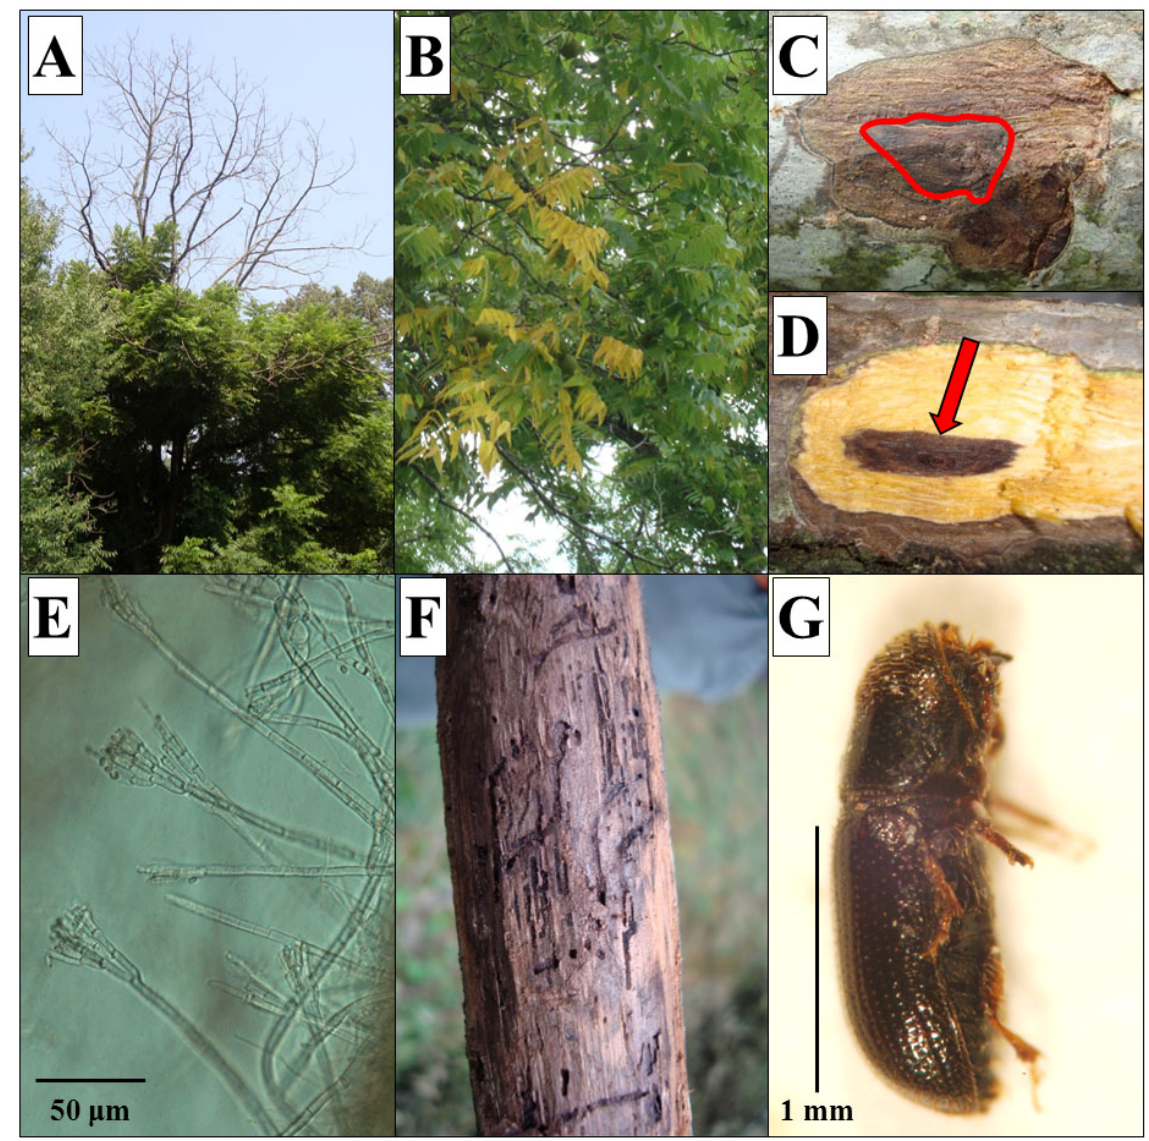
Figure 2. Thousand cankers disease: ( A ) Symptomatic black walnut tree infested with walnut twig beetle and Geosmithia morbida ; note crown mortality and profusion of epicormic shoots; ( B ) branch flagging, a primary symptom preceding branch dieback; ( C ) canker in living bark tissue; ( D ) canker extending into woody tissue; ( E ) conidiophores of G. morbida isolated from a tree in Knox Co.; ( F ) galleries made by walnut twig beetle; and ( G ) adult walnut twig